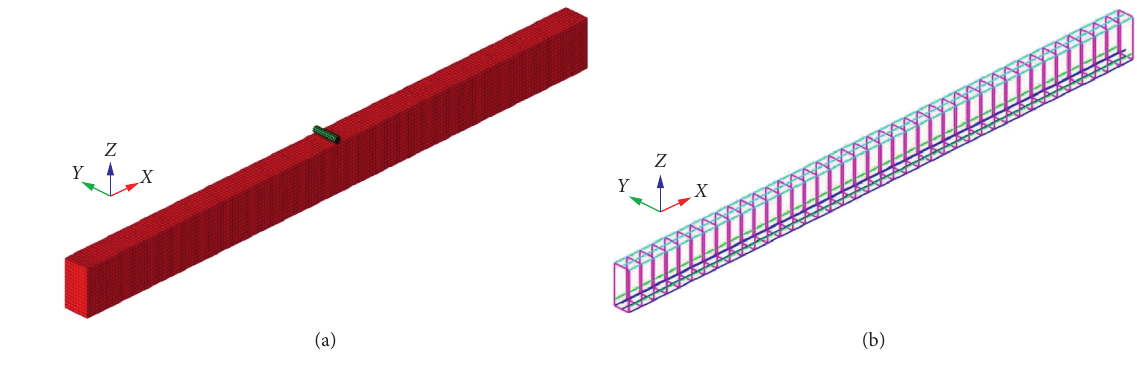
Figure 5: Mesh design for concrete solids and reinforcement bars. Table 1: Concrete material properties.